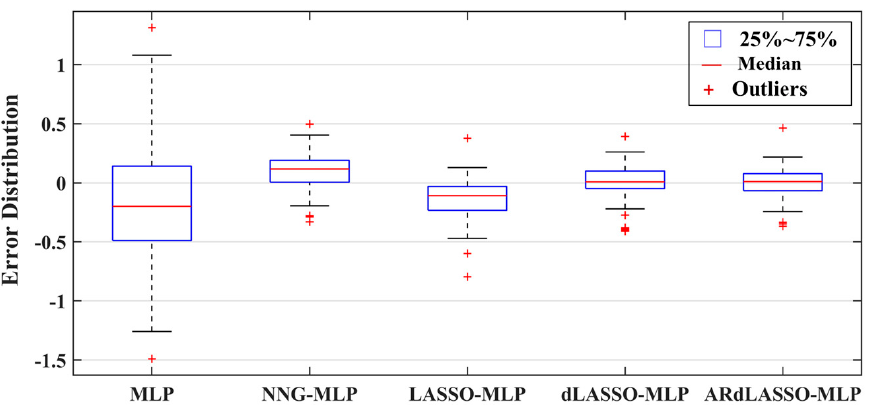
Figure 8. Error distribution with different algorithms: (a) MLP; (b) NNG-MLP; (c) LASSO-MLP; (d) dLASSO-MLP; (e) RAdLASSO-MLP.